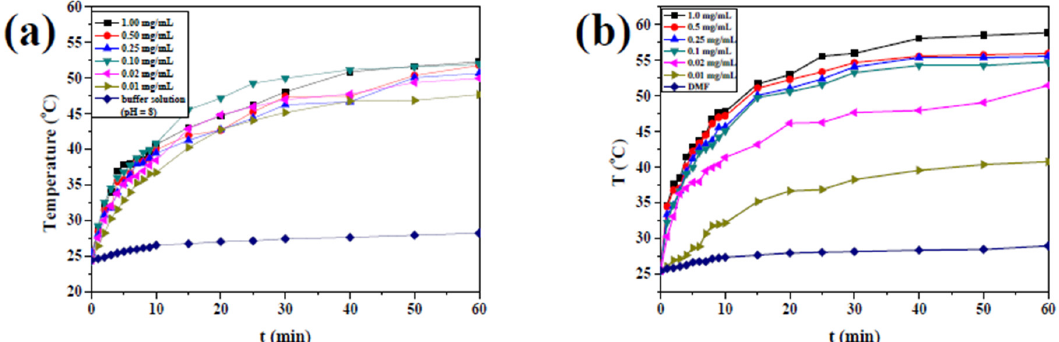
Figure 2. ( a ) Temperature change curves of NIR 800 at different concentrations in buffer solution (pH = 8.0) over a period of 60 min under irradiation with NIR light ( λ max = 810 nm, 0.028 W/cm 2 ). ( b ) Temperature change curves of NIR 800 at different concentrations in DMF over a period of 60 min under irradiation with NIR light ( λ max = 810 nm, 0.028 W/cm 2 ).